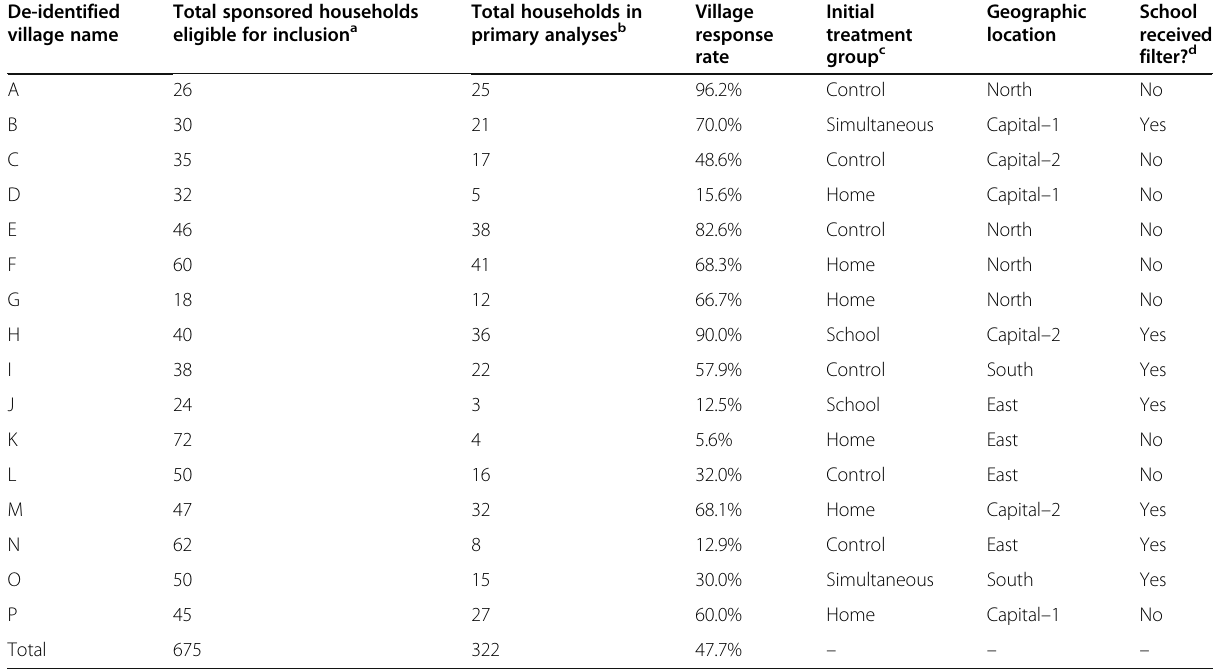
Table 1 Household characteristics by village De-identified village